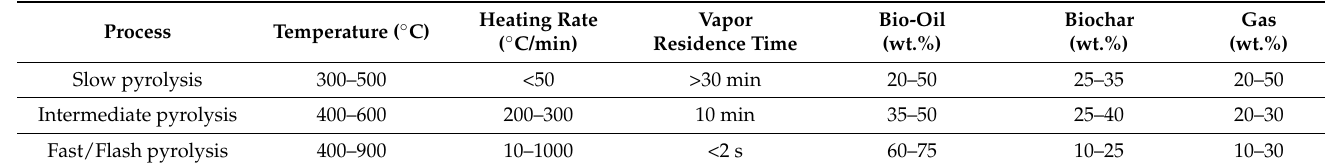
Table 2. Typical operating conditions for slow, intermediate and fast